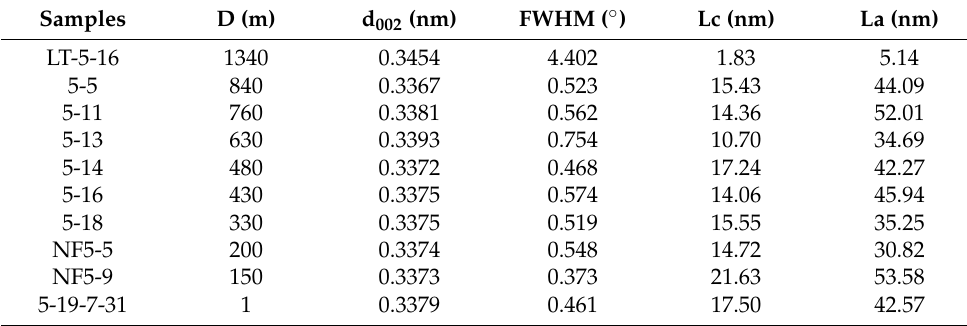
Table 2. XRD parameters and optical reflectance of